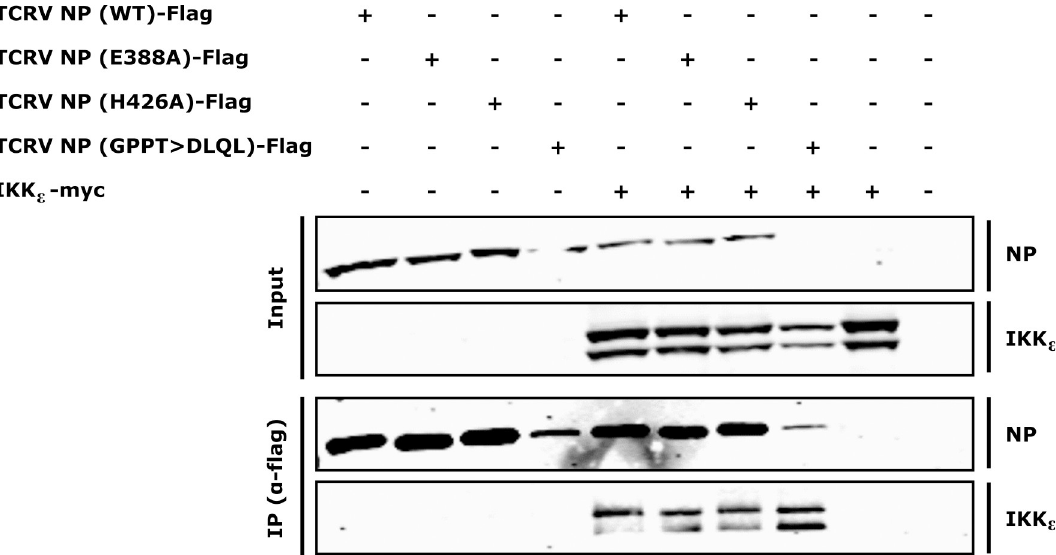
Fig 5. Co-immunoprecipitation of TCRV NP and exonuclease mutants with IKK ε . HEK 293T cells were transfected with plasmids encoding Flag-tagged TCRV NP or its mutants, as well as myc-tagged IKK ε , as indicated. Two days post-transfection cells were lysed and TCRV NP was precipitated with an anti-Flag antibody and input as well as precipitates were analyzed by Western blot. NP and IKK ε were detected with antibodies specific for the Flag- or myc-tag, respectively. A representative result from 3 independent experiments is